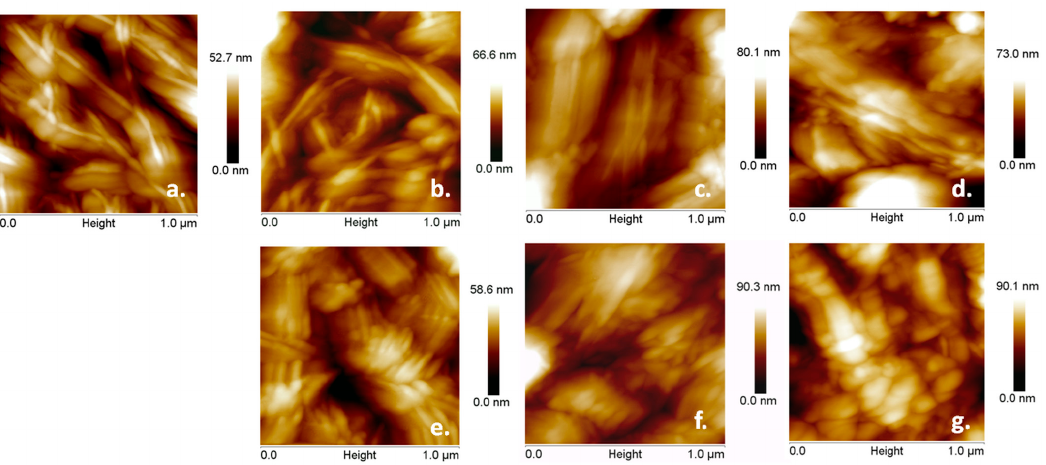
Figure 5. AFM topographic images of untreated ( a ) and plasma treated NC: Ar ( b ); Ar/O 2 ( c ); Ar/N 2 ( d ); Ar/N 2 (E30) ( e ); Ar/NH 3 ( f ); Ar-ACN ( g ).